Question: Express in one sentence what the figure is showing.
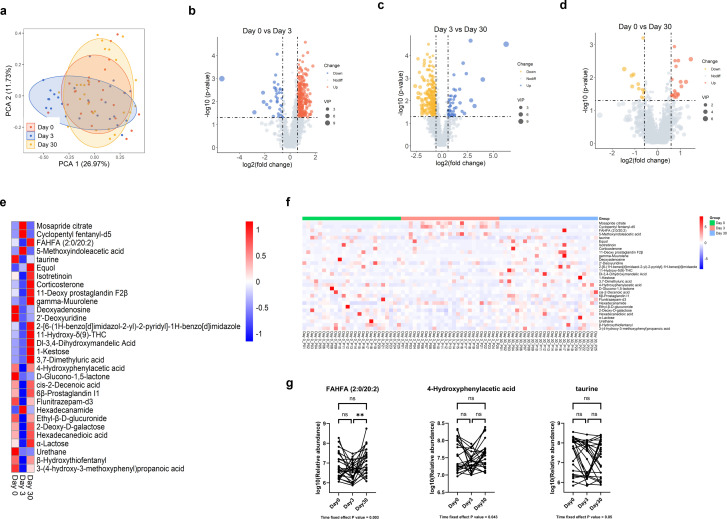
Answer: Alterations of metabolites in papillary thyroid cancer after radical thyroidectomy (PTCRT) patients during RAI therapy. ( a ) Principal component analysis (PCA) of gut metabolites. ( b–d ) Volcano plots of differential metabolites among three groups. ( e ) Heatmap of the top30 differential metabolites among groups. ( f ) Heatmap of the top30 differential metabolites among samples. ( g ) Violin plots of the relative abundances of Fatty acid esters of hydroxy fatty acids (2:0/20:2), 4-hydroxyphenylacetic acid and taurine across different time points. P -values were calculated using linear mixed-effects models (LMMs) with adjustment for age, sex, and time point. ns indicates not significant ( P > 0.05) and ** P < 0.01.